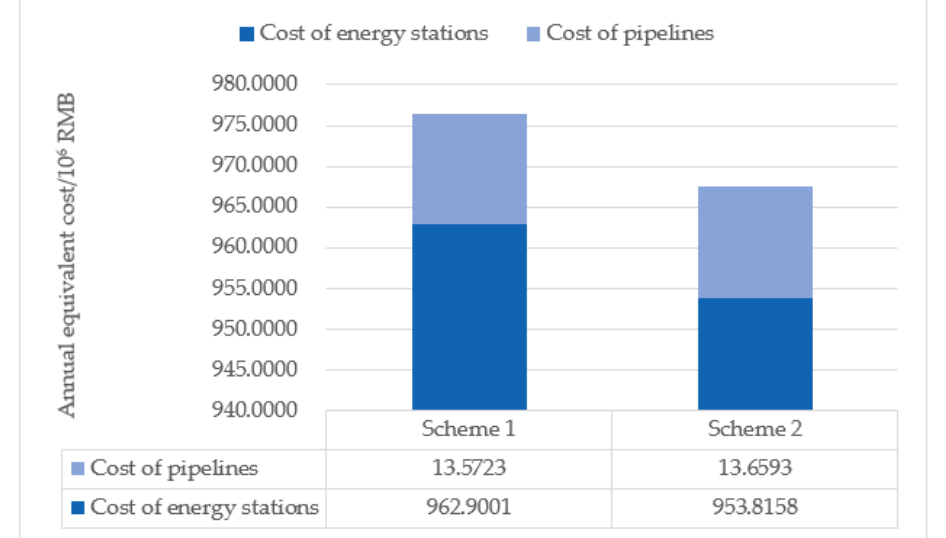
Figure 6. Comparison of two schemes.